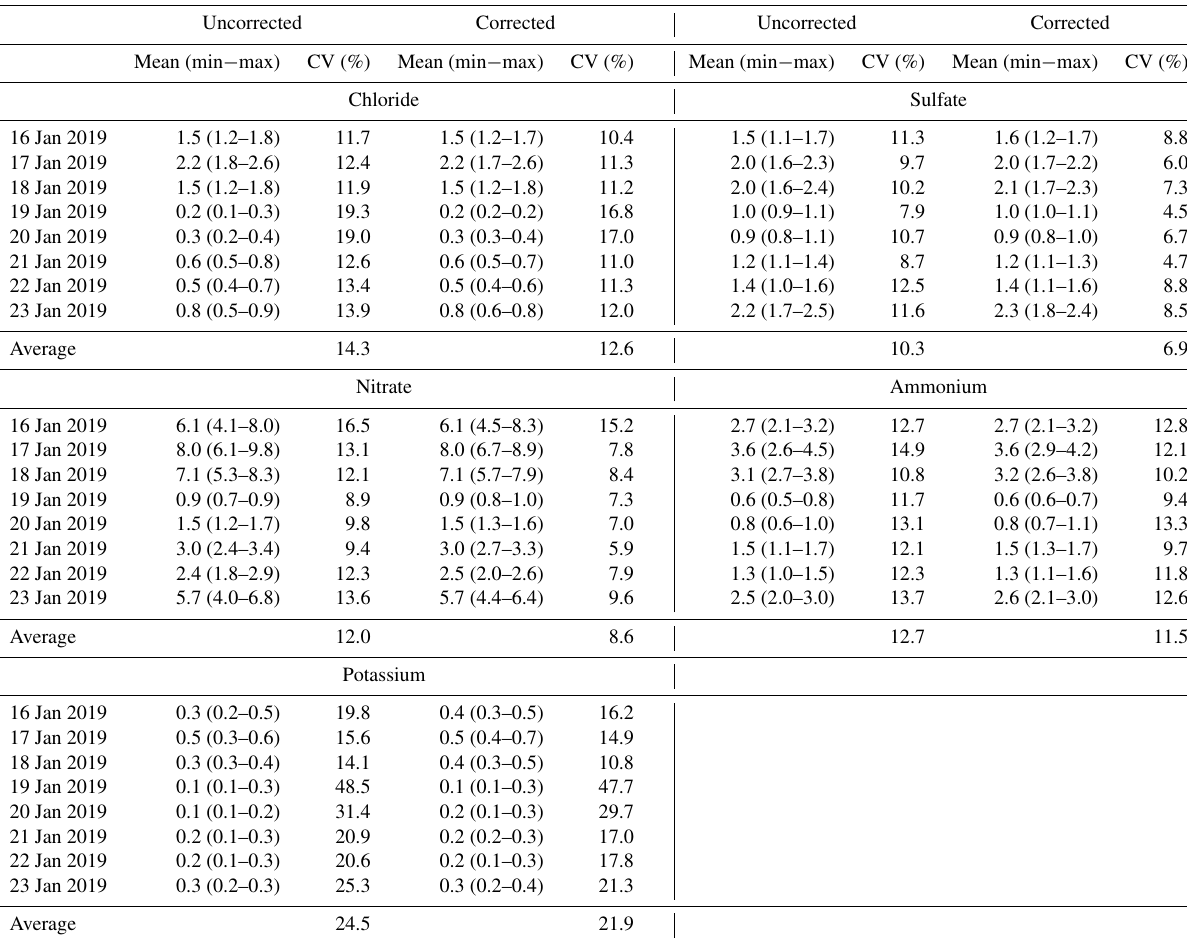
Table 4. Uncorrected and CRM-corrected ion concentrations (µg/m 3 ) and their corresponding coefficients of variation (CVs; %). Uncorrected Corrected Uncorrected